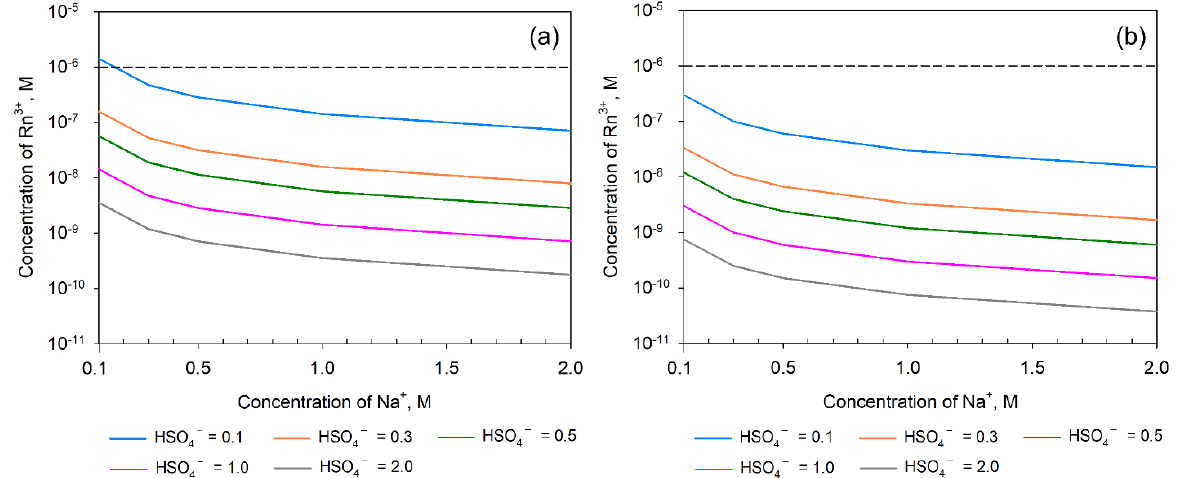
Figure 8. Effect of Na + on the precipitation of Rn 3+ on Na double salt at pH 1 ( a ) and 3 ( b ).